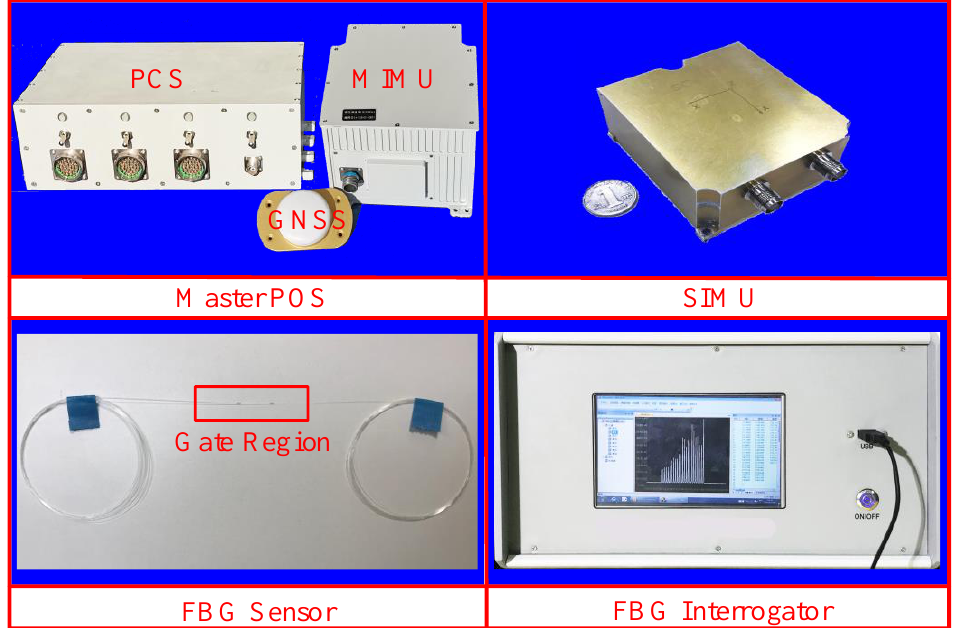
Figure 2. Component of array POS.